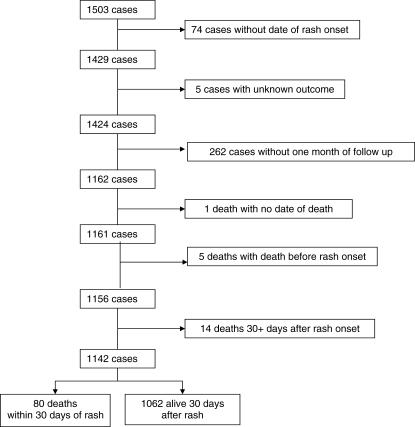
Flow Diagram of Measles Cases Included in the Study, Dong District, Adamawa State, Nigeria (2004–2005)